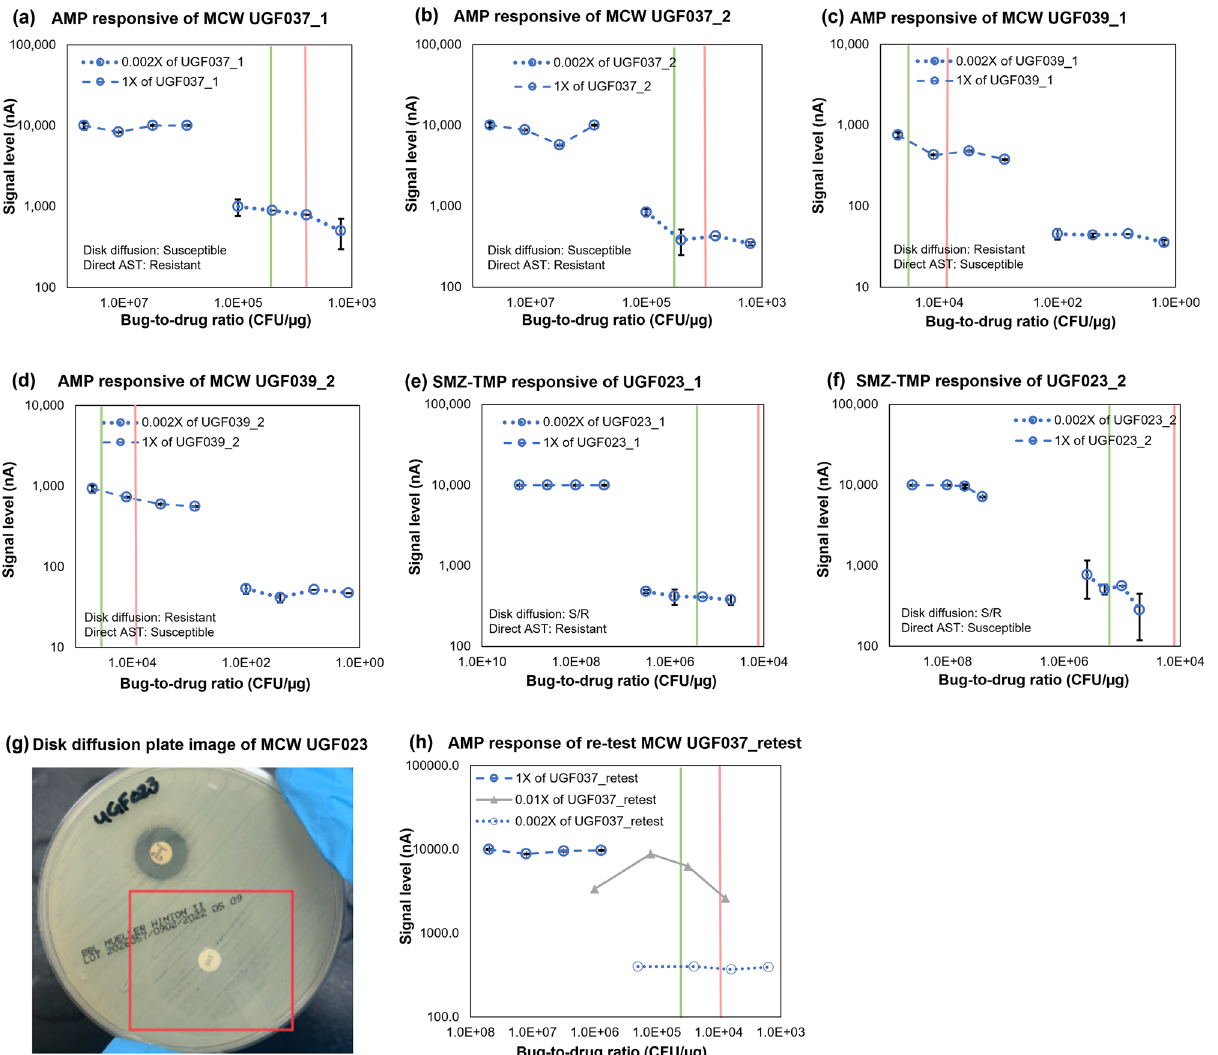
Figure 4. Discrepancies between direct-from-specimen AST and disk diffusion from MCW clinical feasibility studies. ( a – f ) Response curves of discrepancies, ( g ) disk diffusion result for UGF023, ( h ) re-test of UGF037 against ampicillin including extra 0.01× specimen dilution. Each error bar represents 2 data